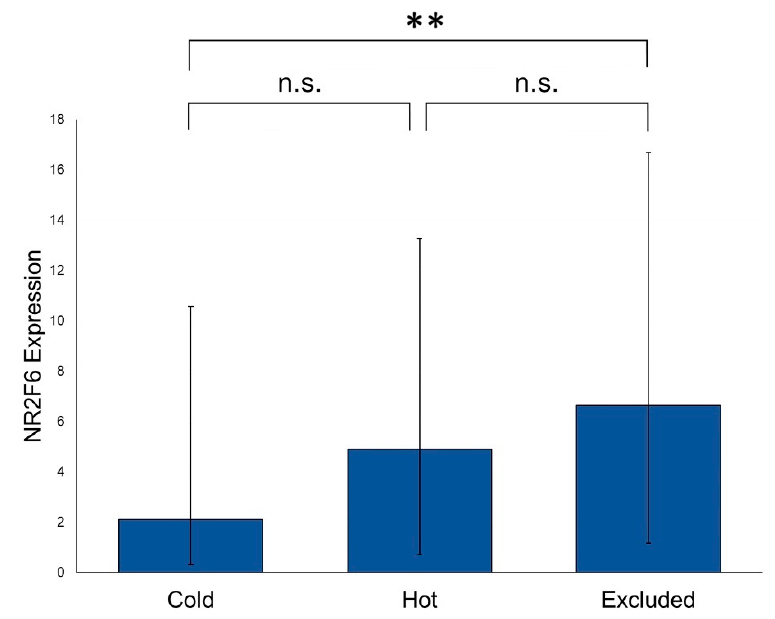
Figure 4. NR2F6 expression in PTs with and without immune cell infiltration. There was a significant difference in the NR2F6 expression between “cold” and “excluded” PTs (Mann–Whitney test, p = 0.006). “Cold” and “hot” PTs and “hot” and “excluded” PTs showed no significant differences, but a trend was visible. (** p ≤ 0.01; n.s. = not significant).